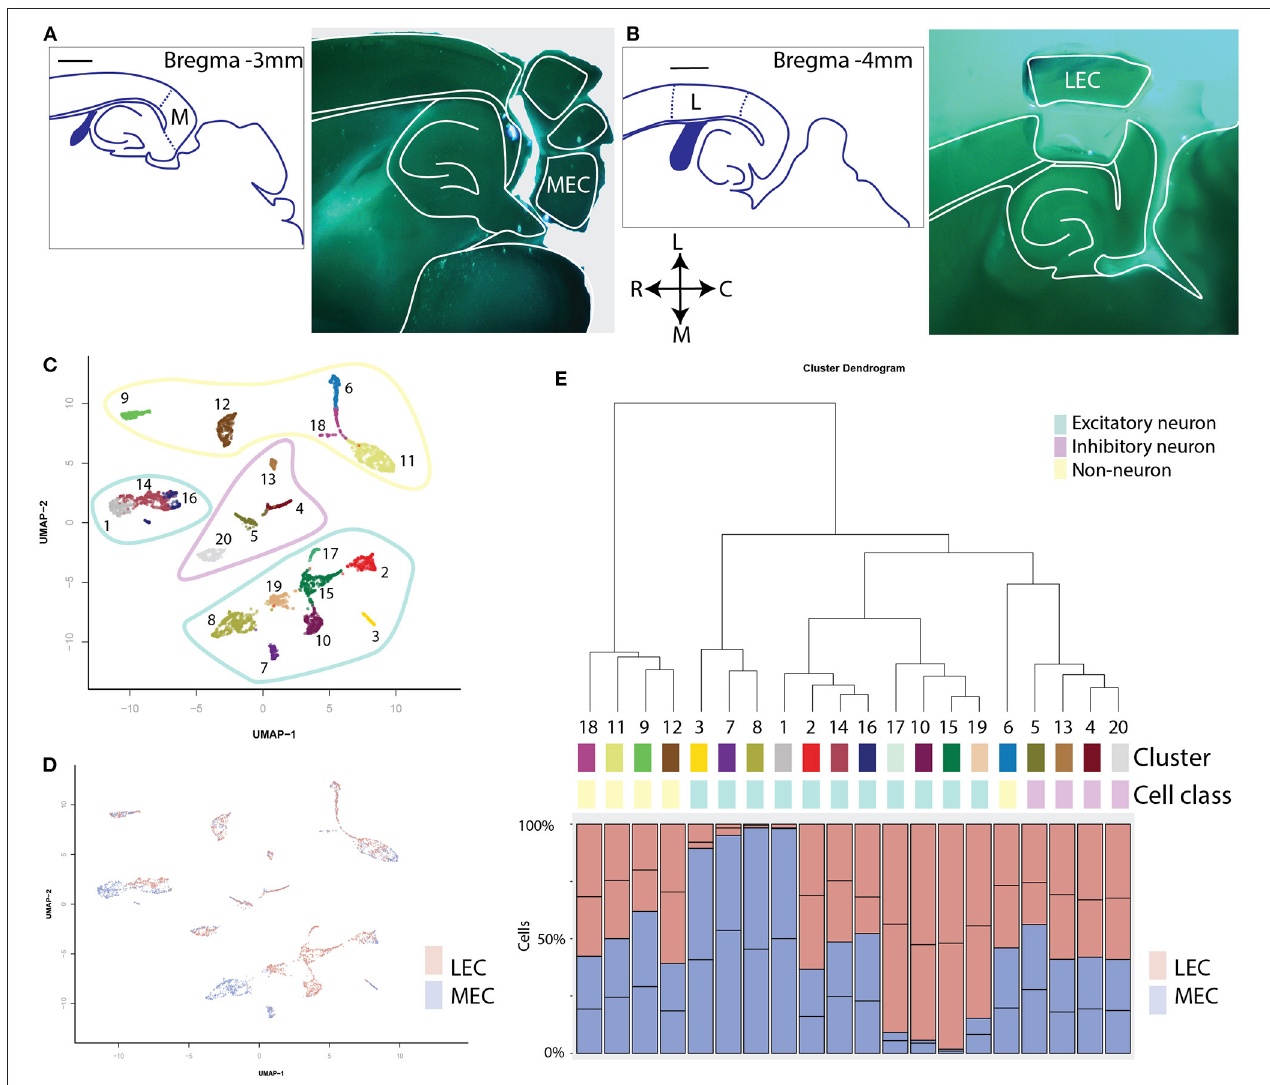
FIGURE 1 | Clustering of all single cells reveals shared and sample-enriched clusters of cells. (A) Left: schematic reference of the tissue, scale bar is 1mm, M indicates the MEC. Right: Example of microdissection of subregions of the EC and approximate level in an anatomical atlas. This section was cut horizontally to optimally allow dissection of both subregions of the EC. (B) Schematic reference and example of microdissection of the lateral subregion of the EC. L indicates the LEC. (C) UMAP projection of all cells profiled with scATAC sequencing. Coloring and labeling indicate cluster numbers of scATAC data used in the rest of this publication. The outlines indicate three different classes of cells: non-neurons (yellow), inhibitory neurons (magenta), and excitatory neurons (cyan). (D) UMAP projection labeled by sample. Note the existence of both mixed clusters and clusters consisting primarily of either MEC or LEC cells. (E) Hierarchical dendrogram of the clusters of scATAC cells with quantification of the contribution of each sample to each cluster. Contributions are given in percentages. Cluster numbers, cell class, and colors correspond with those in (C) .